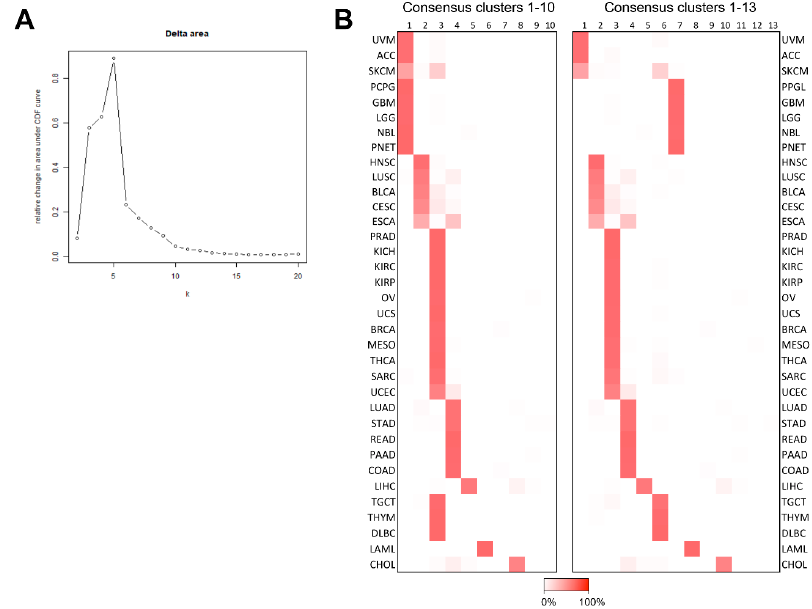
Figure 3. Pan-cancer consensus clustering. Unsupervised consensus clustering of 3319 TCGA and TARGET samples annotated for their specific cancer type. ( A ), Delta CDF plot with information on the additional explanatory power provided through increasing the number of clusters. Y-axis, relative change in the area under CDF curve and y-axis; k , the number of consensus clusters. ( B ) , Proportion of cases assigned to the different clusters ranging from 0% (white) to 100% (red) in both 10 and 13 clusters. X-axis, consensus cluster numbers and y-axis, a cancer type.